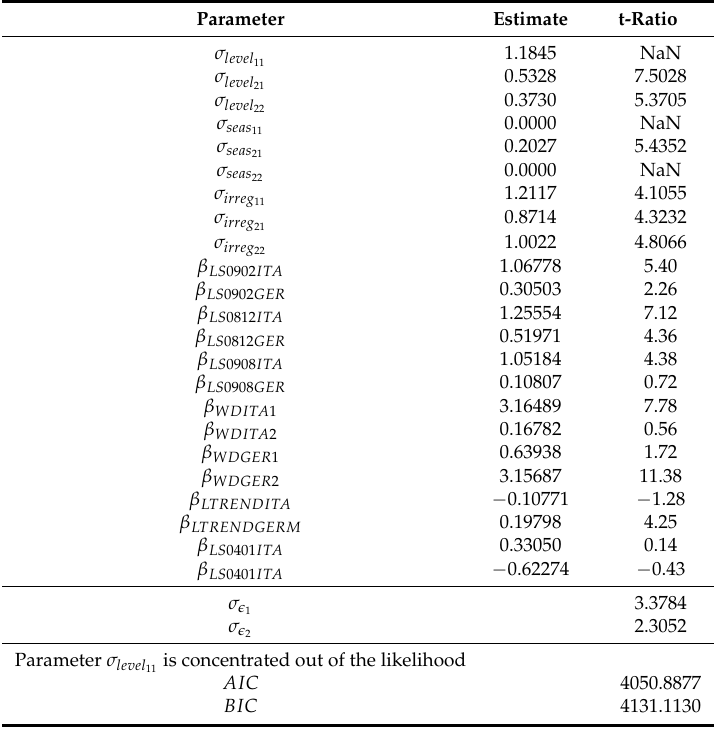
Table A4. Barebone model variables: IPI t intermediate goods TTMI t in Germany.